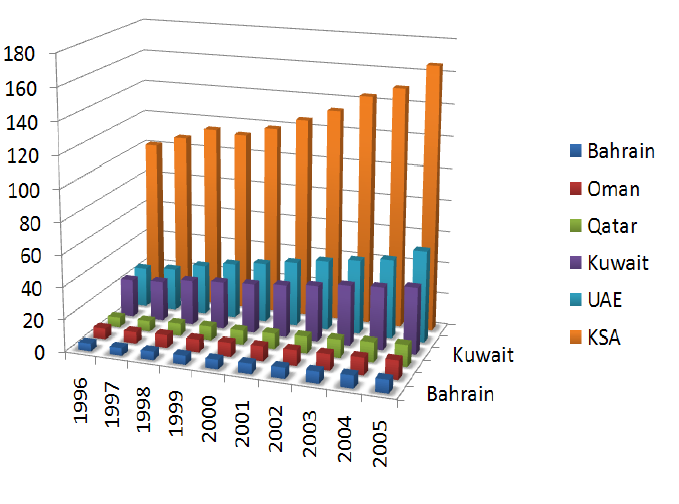
Figure 4. Electricity generation comarison for the six GCC countries.